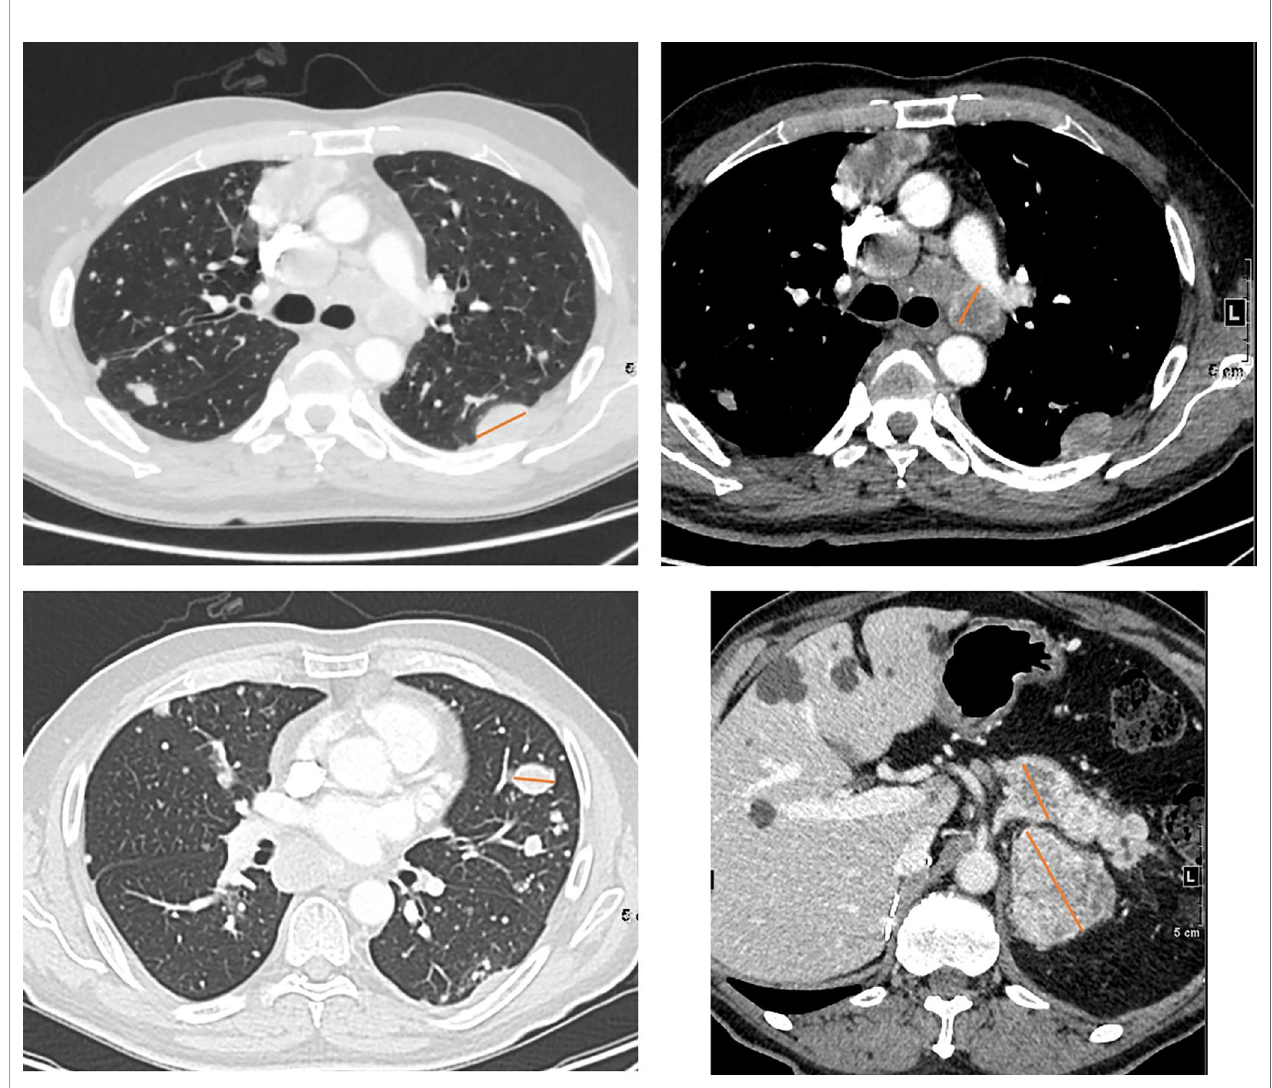
FIGURE 1 | Selecting target lesions in a 58 yo patient with metastatic renal cell carcinoma. Multiple lung, lymph node, pancreatic and adrenal metastases are present. Lymph nodes should be sampled from different locations where possible. Selection of target lesions at baseline from multiple organ sites is important for response evaluation at a patient